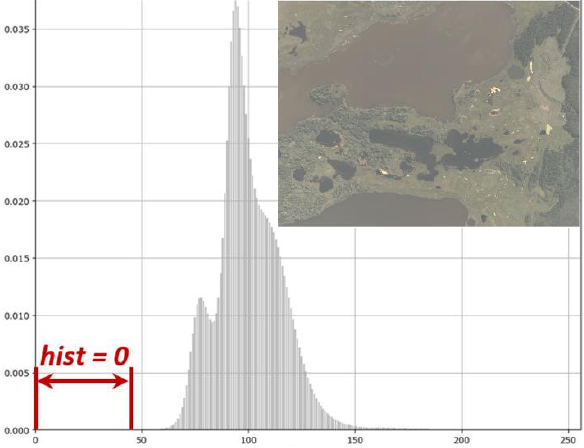
Figure 6. An example of a histogram for aerial image with haze with the distinctive zero values sequence in the area of low pixel brightness 2.1.3 Loss of information in shadows and illumination Why: wrong exposure selection; limitations of the photosensitive matrix’s dynamic range; incorrect images postprocessing. Appearance: polygons of pixels with maximum brightness, indicating the loss of information in illumination; deep shadows on aerial images that prevent identification of objects caught in